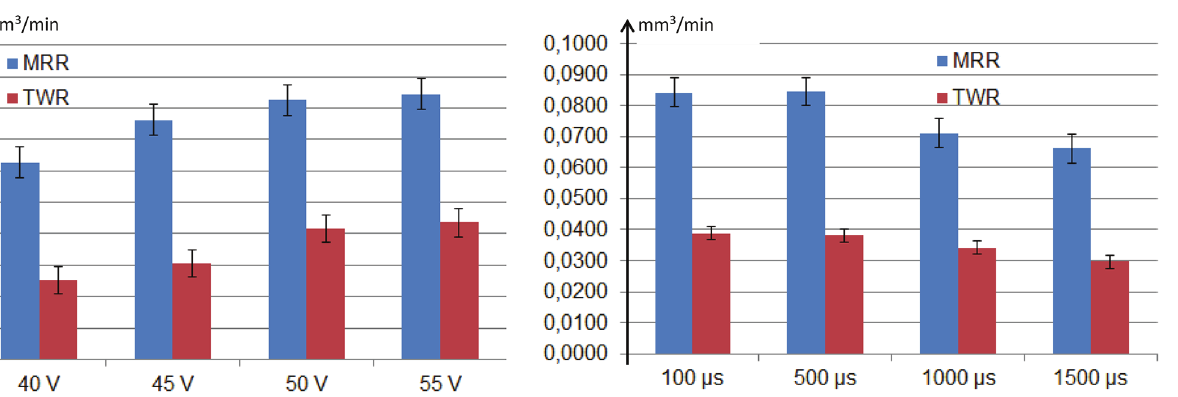
Fig. 6. Effect of T on on MRR and TWR in EDM using coated electrode.